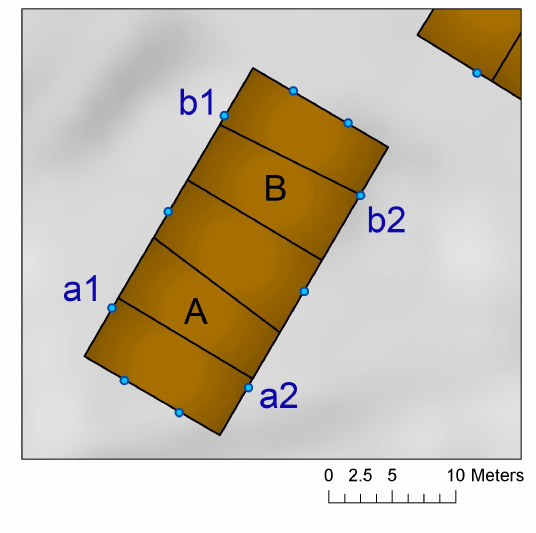
Fig. 3. Façade points and dwelling units within a building showing assignment of the nearest façade point to units with